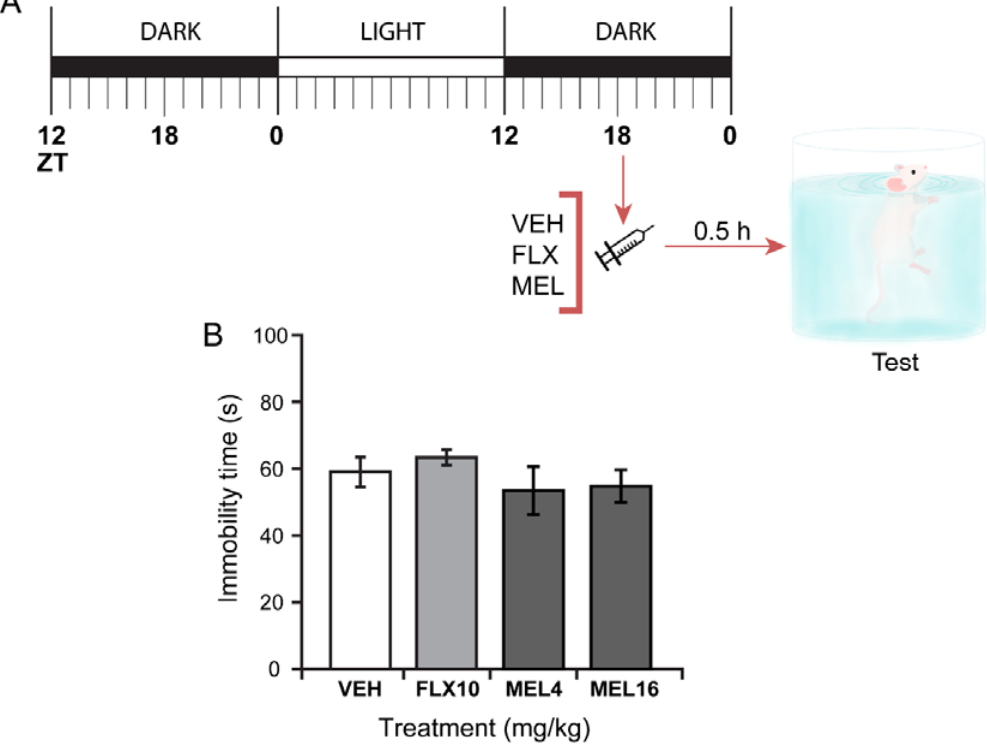
Figure 3. Single melatonin dose at ZT18 on mice forced swimming test (FST). ( A ) Melatonin treatment